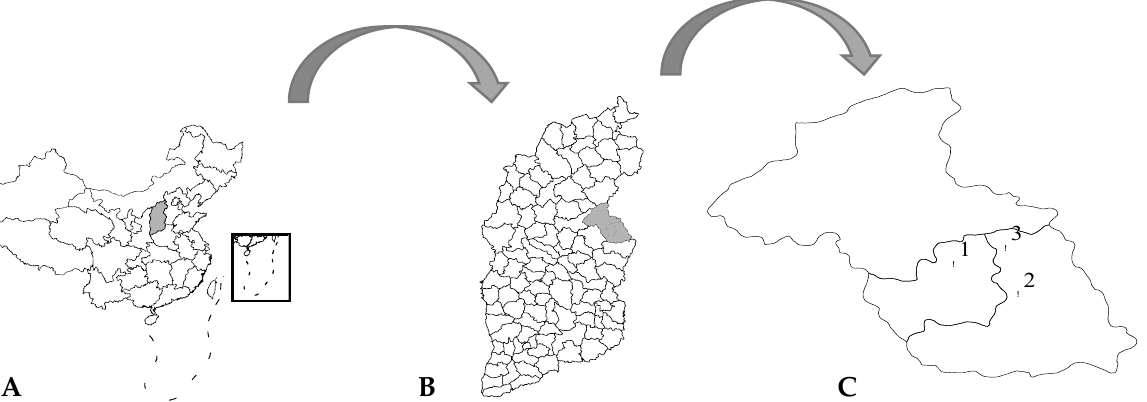
Figure 1. Specimen collection villages in Yangquan County, Shanxi Province, China in 2019. Note: ( A ) The location of Shanxi Province in China. ( B ) The location of Yangquan County in Shanxi Province. ( C ) The geographic location of the three collection villages in Yangquan County. The first sampling village (113 ◦ 33 (cid:48) 51 (cid:48)(cid:48) east longitude, 37 ◦ 59 (cid:48) 48 (cid:48)(cid:48) north latitude) is 18 km from Yangquan County municipality. The second sampling village (113 ◦ 44 (cid:48) 0 (cid:48)(cid:48) east longitude, 37 ◦ 54 (cid:48) 24 (cid:48)(cid:48) north lat- itude) is 21.3 km from Yangquan County municipality. The third sampling village (113 ◦ 42 (cid:48) 1 (cid:48)(cid:48) east longitude, 38 ◦ 2 (cid:48) 41 (cid:48)(cid:48) north latitude) is 28.8 km from Yangquan County municipality. The distances among the three sampled villages are 15–30